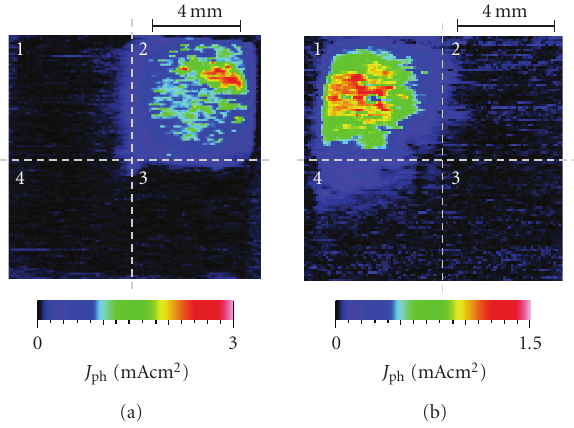
Figure 2: Photocurrent images of dye sensitized solar cells (nanocrystalline zinc oxide) subdivided into four sections for combinatorial testing (clock-wise from top left): (a) neutral red, N3-dye, rhodamine B, methylene blue; (b) N3-dye, neutral red, methylene blue, bromothymol blue. It is seen that only the N3 dye shows significant